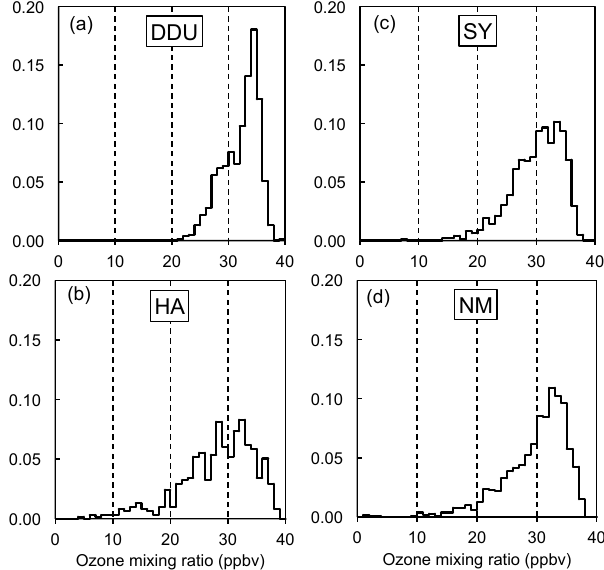
Figure 15. Frequency distribution of daily averaged ozone mixing ratios observed in August, September, and October (2004–2014) the coastal sites of Dumont d’Urville (a) , Halley (b) , Syowa (c) , and Neumayer (d)